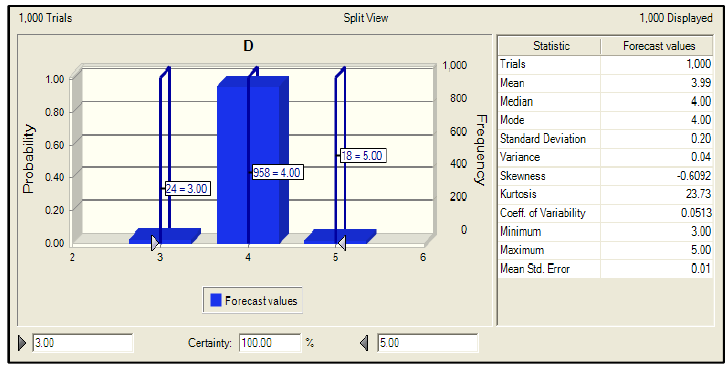
Figure 17. Case 2: Monte Carlo simulation of D in CB software.